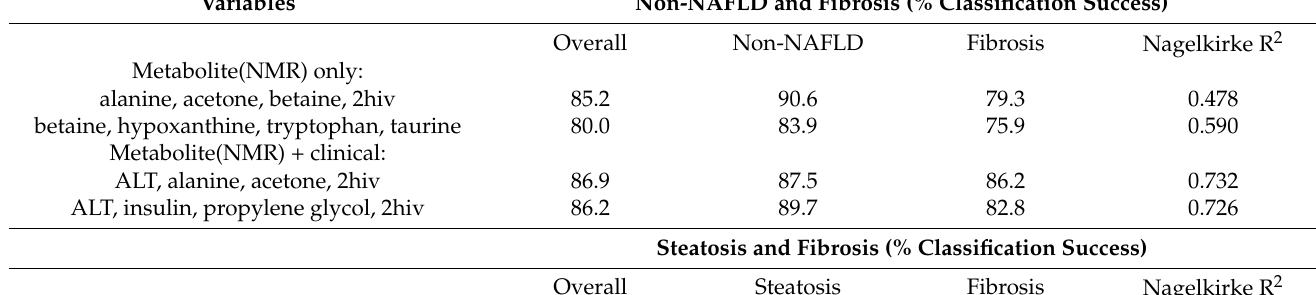
Table 5. Exploratory logistic regression modeling shows that small numbers of NMR-derived aqueous metabolites are sensitive to NAFLD progression in non-clinical groups, and further that a complementary interaction of clinical variables is obtained. A particularly productive combination of alanine and ALT (alanine aminotransferase) is observed in this work. Variables Non-NAFLD and Fibrosis (% Classification Success) Overall Non-NAFLD Fibrosis Nagelkirke R 2 Metabolite(NMR) only: